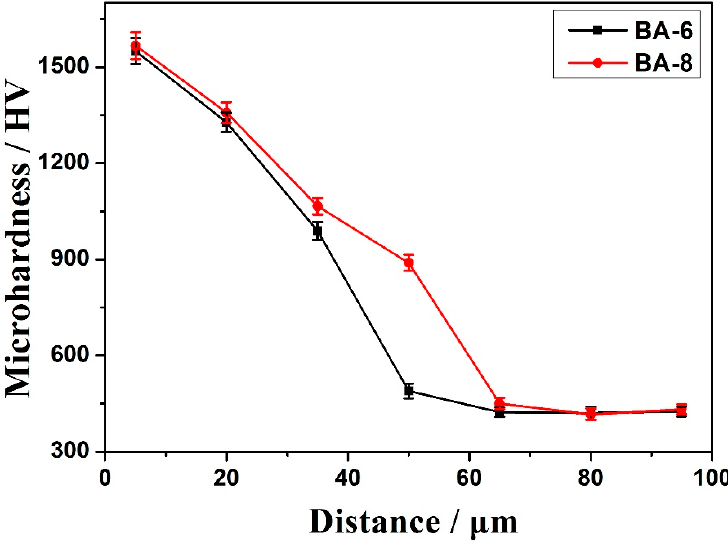
Figure 9. Hardness profiles from the outermost produced layer to the substrate.